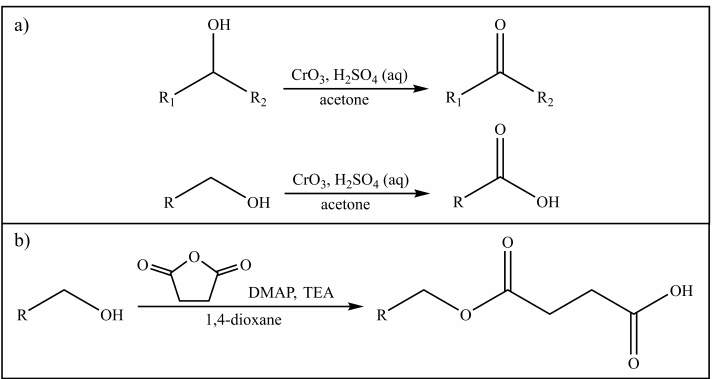
Figure 3. Generic reaction schemes that can be used to convert primary hydroxyl (-OH) groups into functionalizable carboxylic groups using ( a ) Jones oxidation and ( b ) esterification using an acid anhydride (succinic anhydride, in this